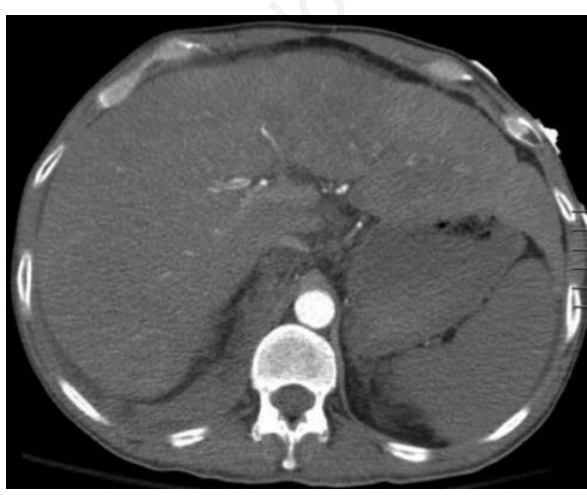
Figure 2. Massive hepatomegaly measuring 27.2 cm in cranio- caudal dimension.